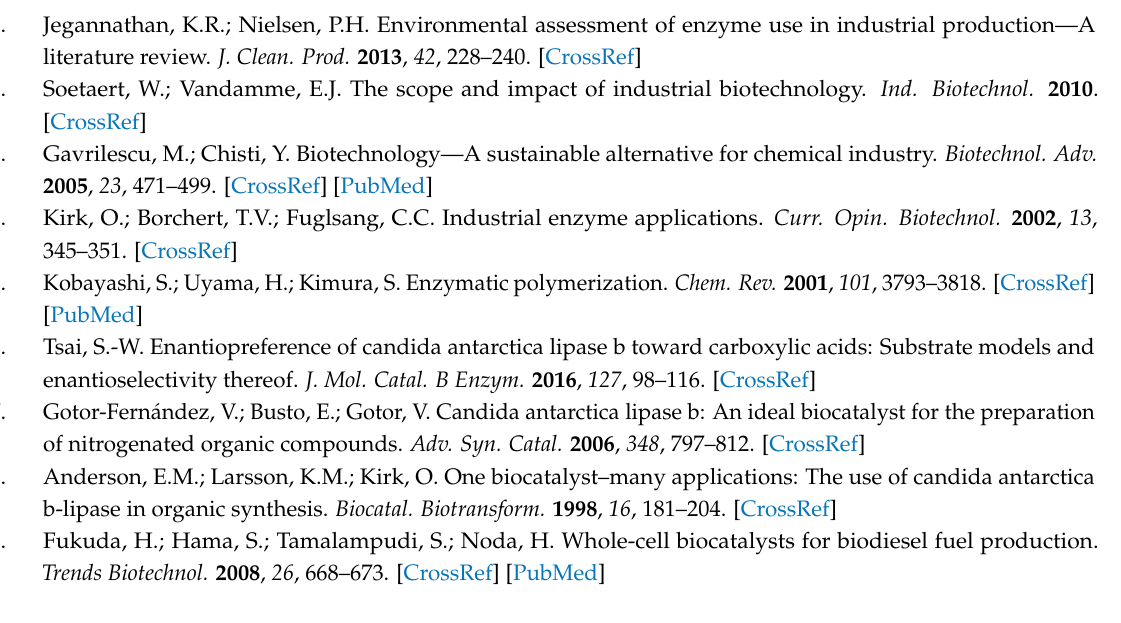
Figure S1: TEM micrographs of (a) pristine nanoparticles, (b) CA-coated NPs. (c) SA-coated NPs. (d) OA-coated NPs. (e) CALB EDA @CA-NPs. (f) CALB EDA @SA-NPs. (g) CALB EDA @OA-NPs, Figure S2: FTIR spectra of citric acid and succinic anhydride-coated NP compared to free citric acid and succinic anhydride molecules, Table